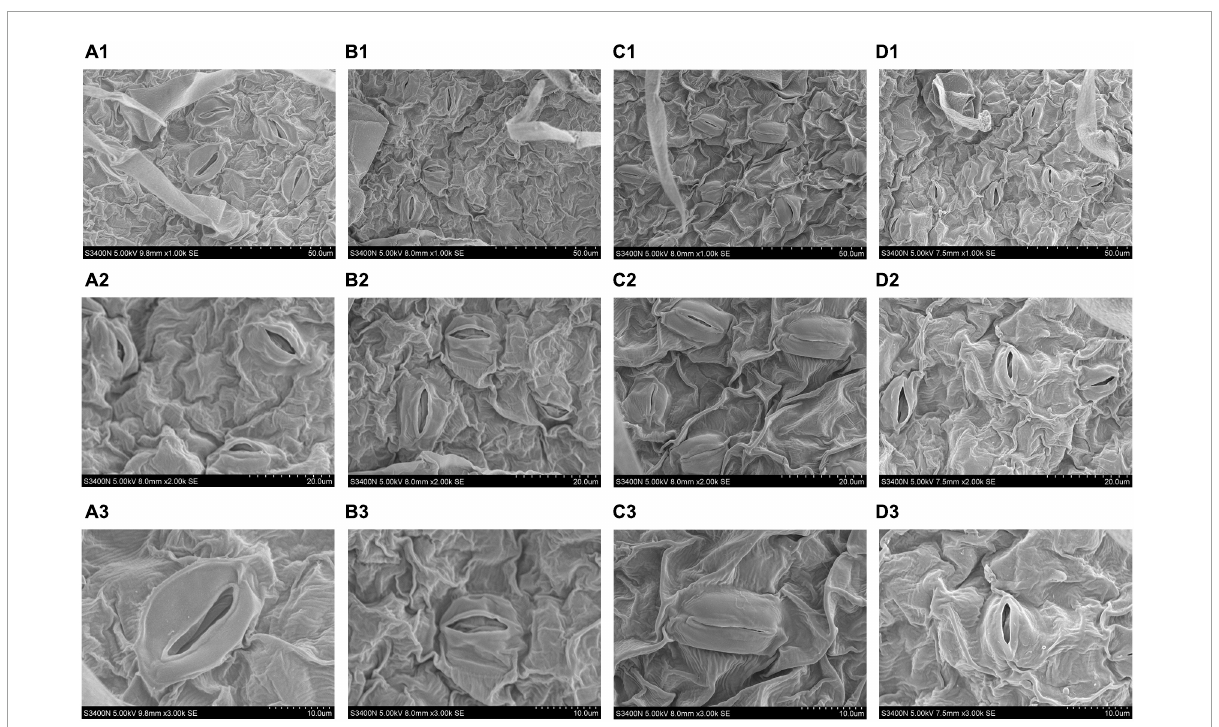
FIGURE3 Effects of Tre treatment on stomatal characteristics of tomato seedlings exposed to salt stress for 5 days. Panels (A1–D1) represent stomatal distribution of tomato leaves in CK, T, S and S+T, respectively, 1,000 × , scale bars = 50 µ m; Panels (A2–D2) represent stomatal characteristics in CK-S+T, 2,000 × , scale bars = 20 µ m. Panels (A3–D3) represent stomatal characteristics in CK-S+T, 3,000 × , scale bars = 10 µ